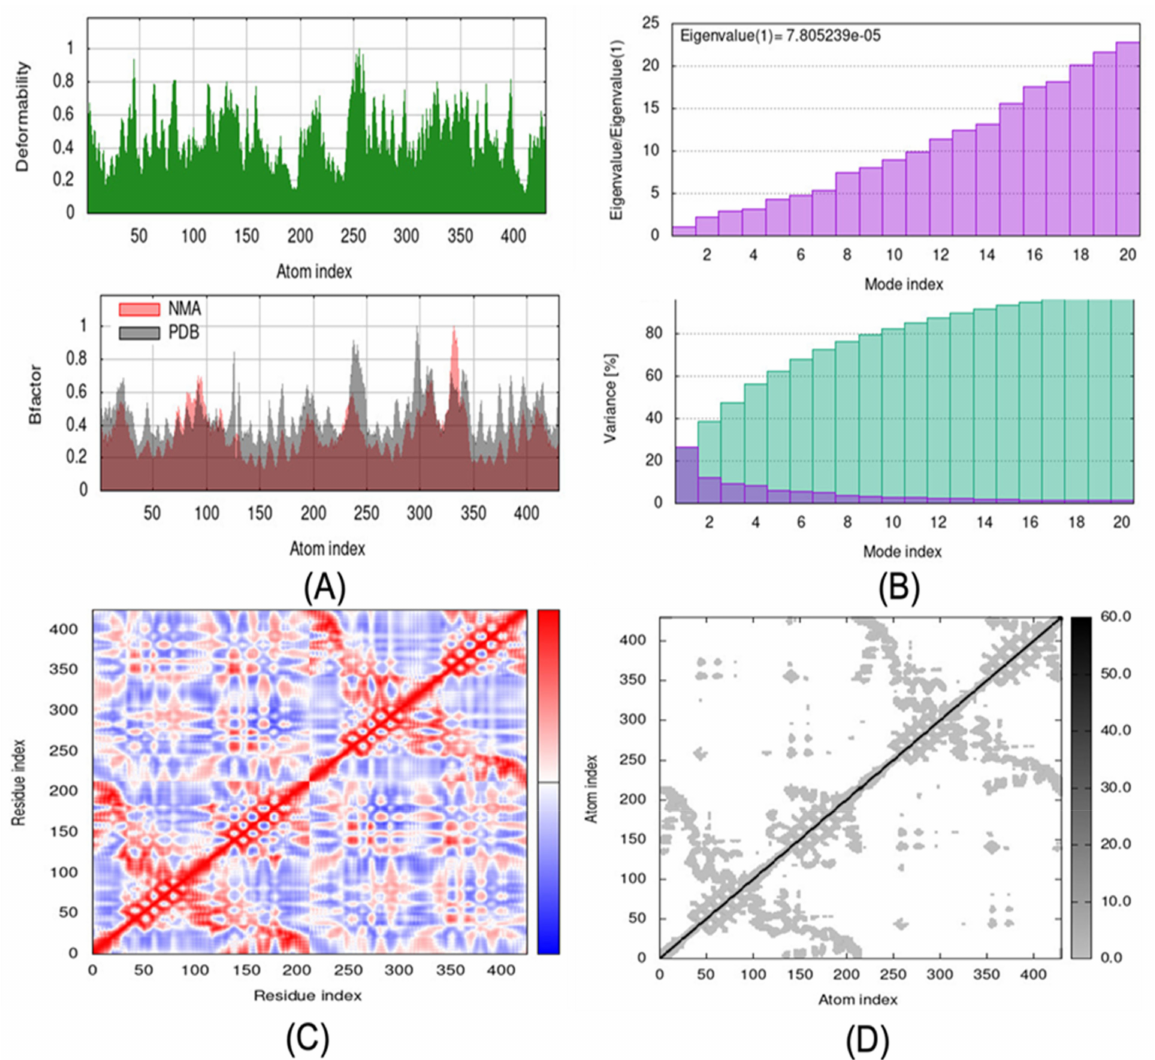
Figure 7. Results of PLK2-11364421 molecular dynamics simulations using iMODS: ( A ) deformability and B-factor plots; ( B ) eigenvalue and variance plots (Colored bars show the individual (purpule) and cumulative (green) variances.); ( C ) elastic network model; and ( D ) covariance